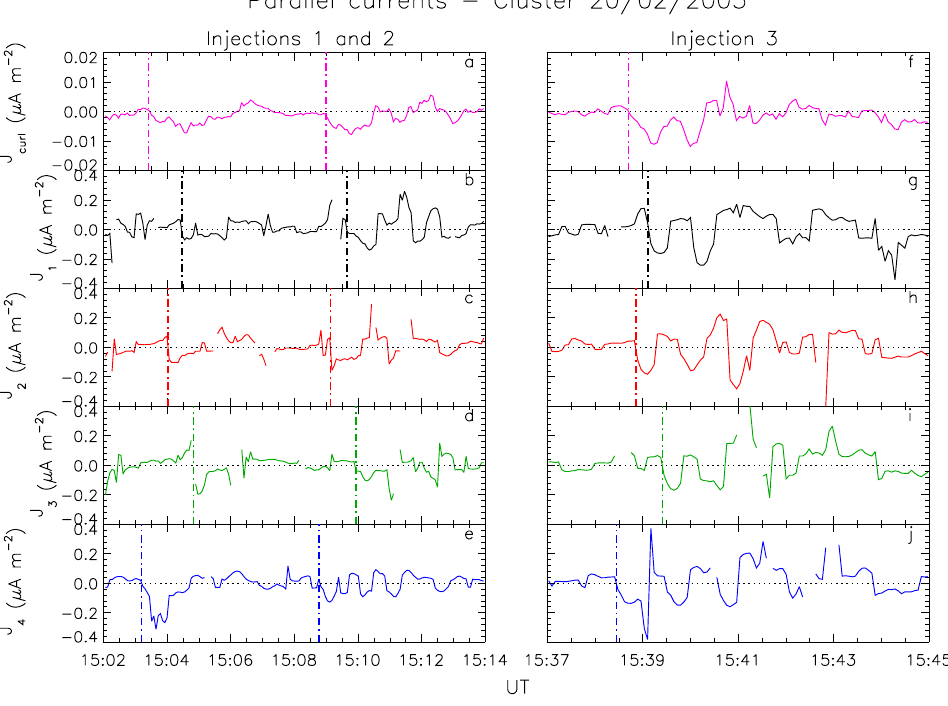
Fig. 10. FGM field-aligned currents calculated with the curlometer method (pink line) and with the single-spacecraft method with zero sheet velocity (black line for sc-1, red for sc-2, green for sc-3 and blue for sc-4). Upward currents are positive. (a) to (e) for the 15:02–15:14UT period (Injections 1 and 2). (f) to (j) for the 15:37–15:45UT period (Injection